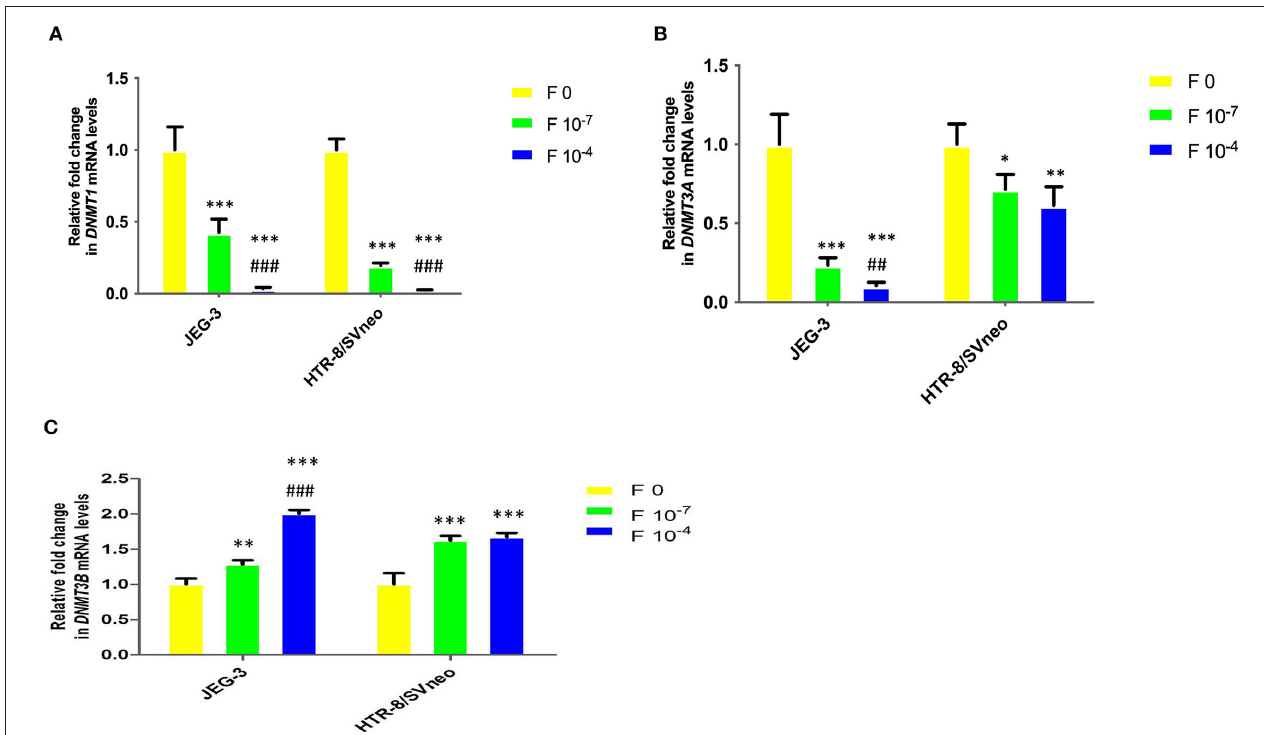
FIGURE 7 | Relative fold change in mRNA levels of DNMTs upon folic acidsupplementation in JEG-3 and HTR-8/SVneo cells. (A) DNMT1, (B) DNMT3A, and (C) DNMT3B. F0- without folic acid supplementation, F10 − 7 and F10 − 4 - folic acid supplementation at the concentration of F10 − 7 and F10 − 4 M, respectively. The data are expressed as mean fold change ± SEM of three experiments. * p < 0.05, ** p < 0.01, *** p < 0.001 with respect to the respective F0 control and ## p < 0.01 and ### p < 0.001 with respect to respective F10-7 treated